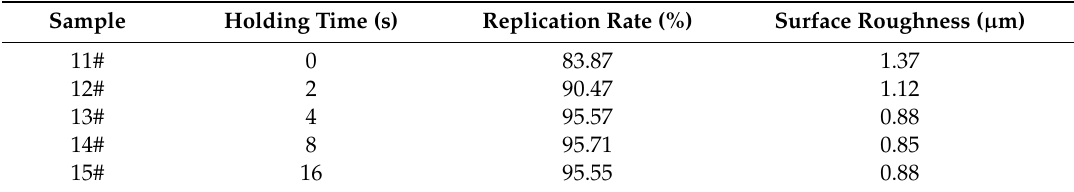
Table 4. Replication rate and surface roughness of micro-structured part fabricated under different holding times.